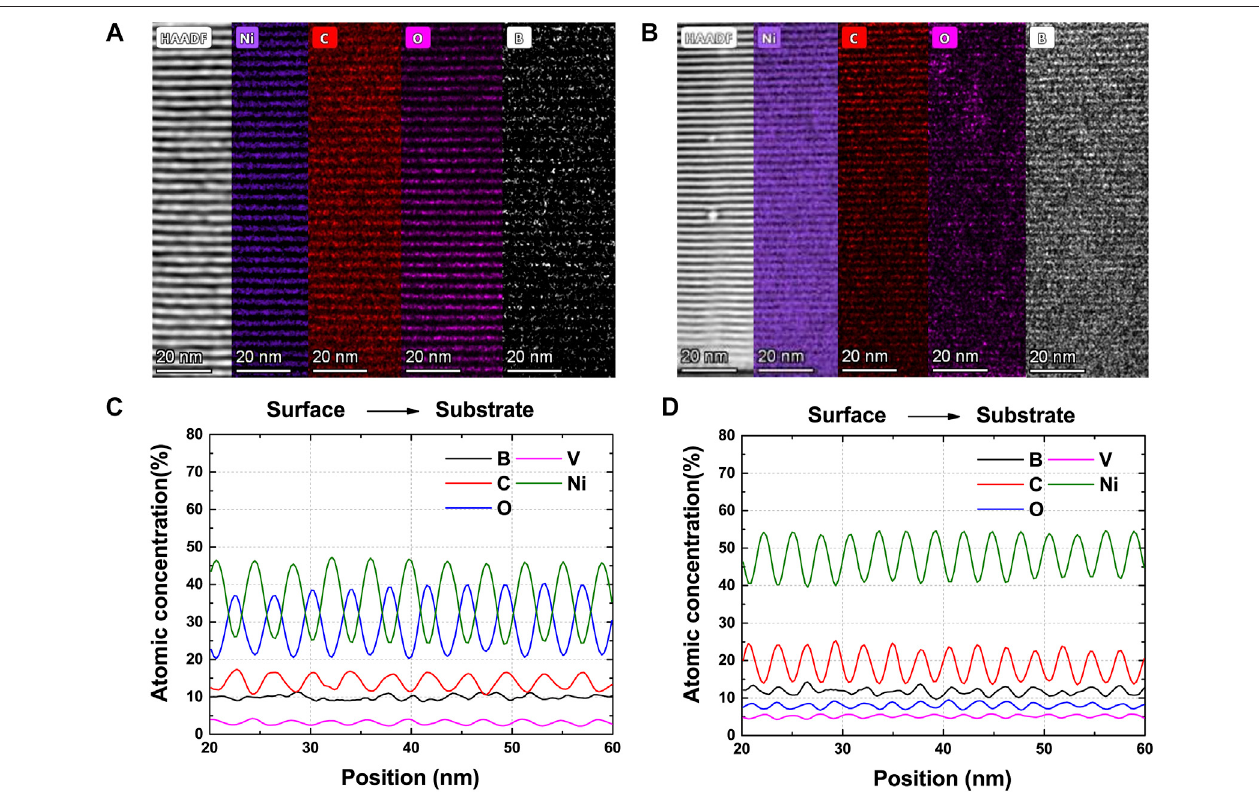
FIGURE3| Electron-dispersivex-ray spectroscopy (EDX)mapping-scan and line-scan (fromsurfacetosubstrate) measurements ofchemicalelements intheNiV/ B 4 C multilayers fabricated with background pressures of 4 × 10 − 4 Pa (A,C) and 4 × 10 − 5 Pa (B,D) .